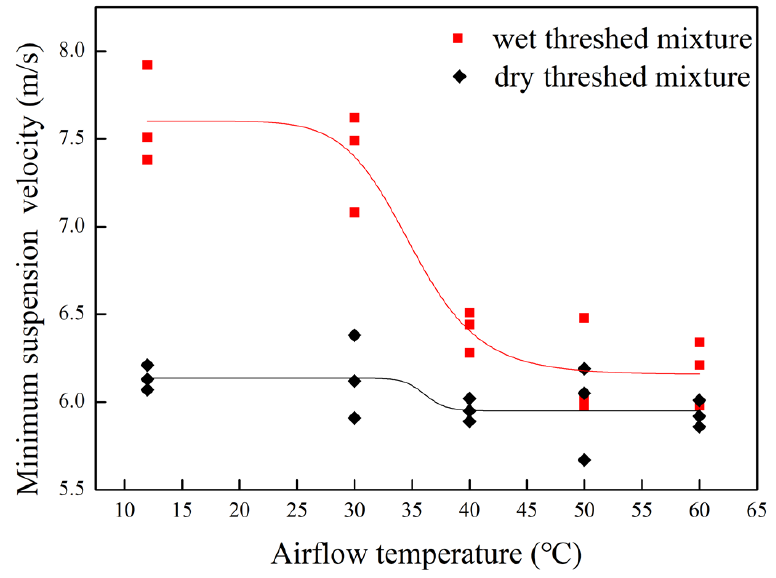
Figure 4. Minimum suspension velocity with temperature. The time when most threshed mixture begin to be suspended in the test bed was defined as the fastest suspension time. Figure 5 shows the fastest suspension time at different airflow temperatures. A decrease in the fastest suspension time with increasing temperature was observed to occur for the wet threshed mixture. In comparison to the dry rice threshed mixture, the fastest suspension time of the wet rice threshed mixture was 27.3 s at the airflow temperature of 12 ◦ C, which was 25 times longer than that